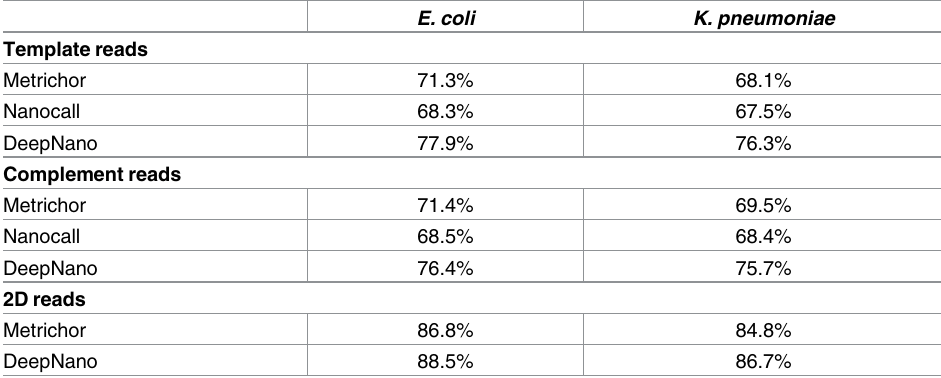
Table 1. Accuracy of base callers on two R7.3 testing data sets. The results of base callingwere aligned to the reference using BWA-MEM [28]. The accuracy was computed as the numberof matches in the align- ment dividedby the length of the